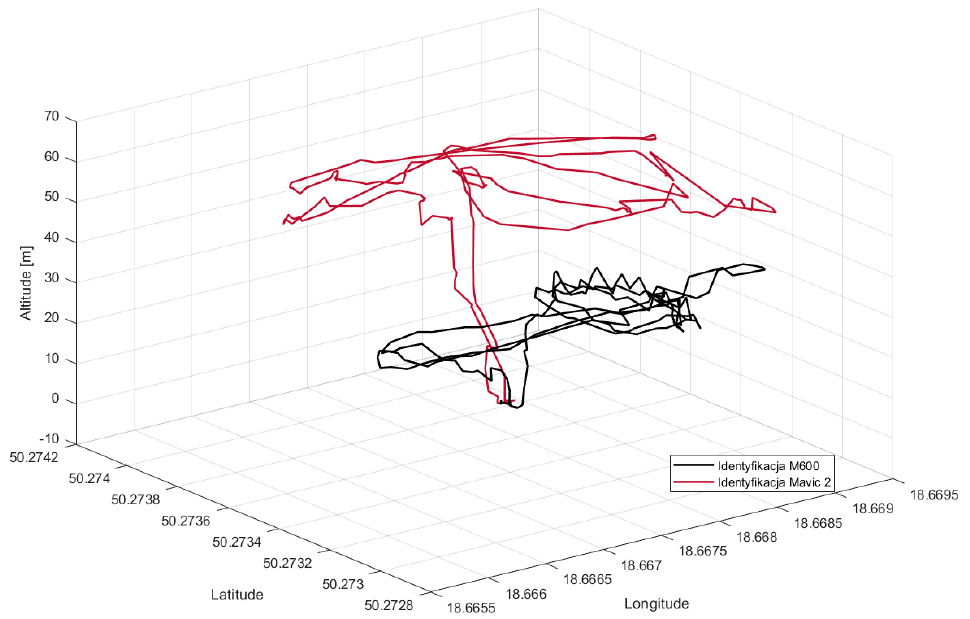
− final result of data